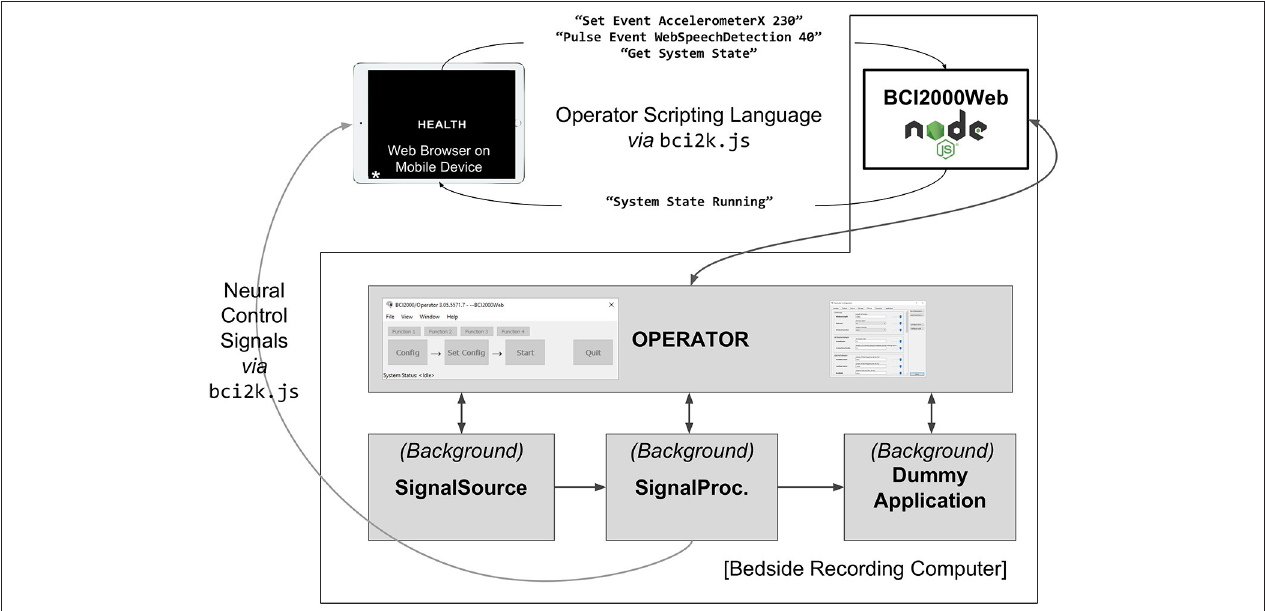
FIGURE 5 | A system diagram depicting an experiment implemented in browser JavaScript running on an independent mobile device. The mobile device is running an experimenter-implemented web-page in fullscreen mode which communicates directly with BCI2000Web for event logging as well as the Signal Processing module for receiving extracted neural control signals. A JavaScript package, bci2k.js, manages WebSocket connections that handle transmission of operator scripting language commands and decodes neural control signals from a binary format. The mobile device is running a word reading paradigm (with the stimulus “HEALTH” currently presented) that has defined asynchronous experimental states including markers for automated vocal transcription onsets using the WebSpeech API. A query for system state is also relayed by the BCI2000Web server. The benefit of such an architecture is that the patient interface is separated from the bedside clinical acquisition machine and can be left with the patient without concern of the patient manipulating the clinical